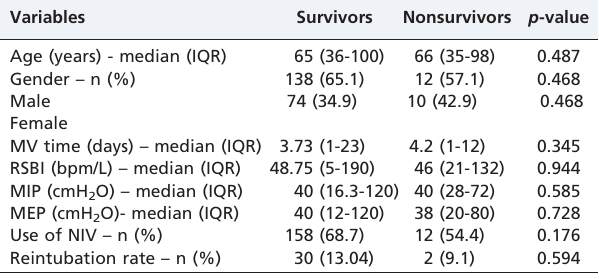
Table 3 - Comparison of patient characteristics between survivors and